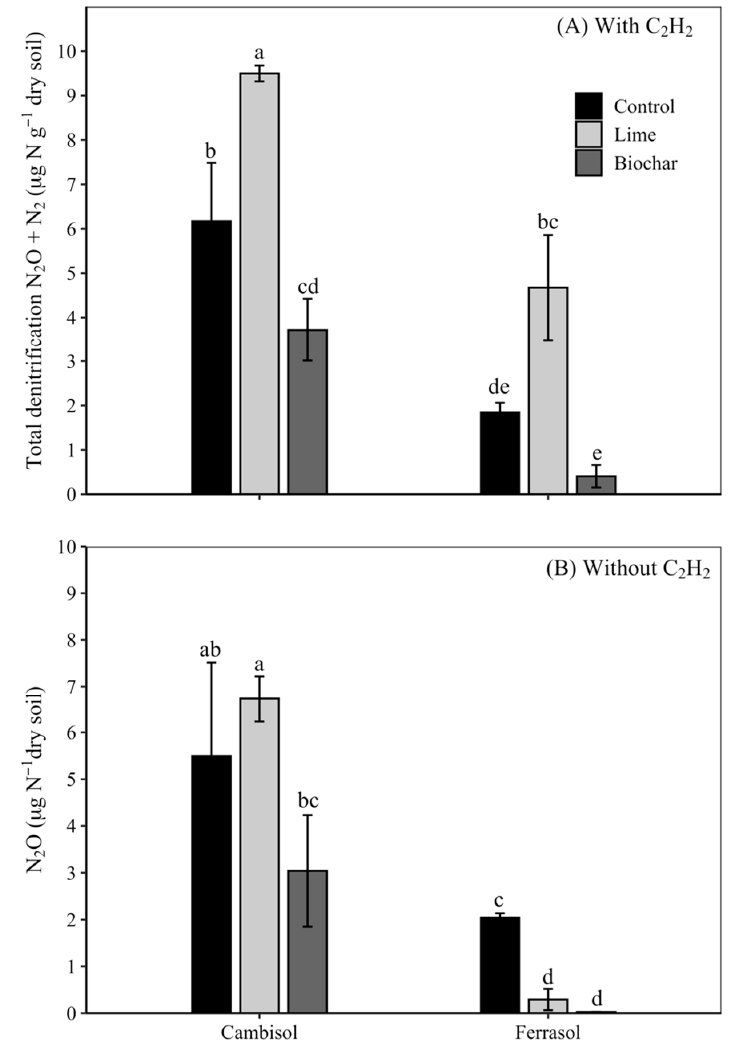
Figure 1. Total denitrification (N 2 O + N 2 ) and cumulative nitrous oxide (N 2 O) fluxes from a temperate Cambisol and a tropical Ferralsol after 12 h of incubation with ( A ) and without ( B ) acetylene (C 2 H 2 ) enrichment. Error bars represent one standard error of the mean. Table 1. Soil pH, proportion of N 2 O to total denitrification (N 2 O / N 2 O + N 2 ), denitrifying gene abundances ( nirK, nirS , and nosZ ), and Shannon diversity index (H ′ ) of nosZ terminal restriction fragment (T-RF) responses to biochar and lime amendments in a Cambisol and Ferralsol. Soil